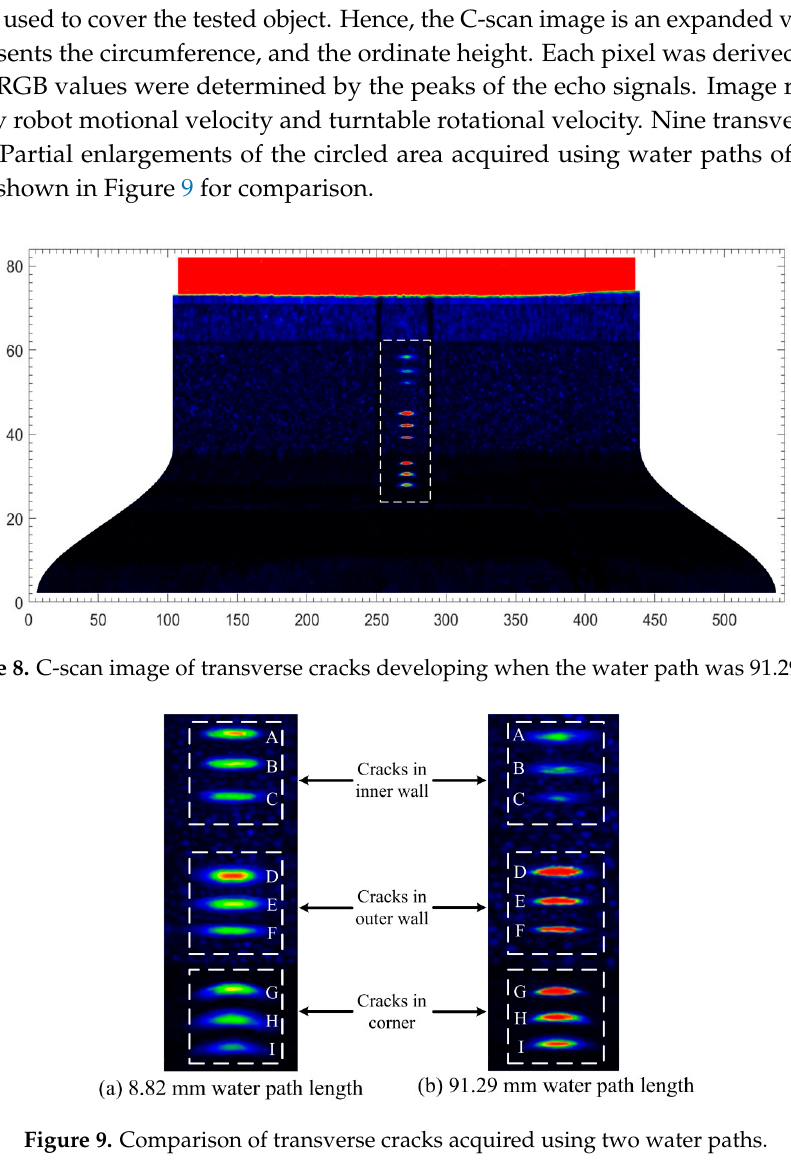
Figure 9. Comparison of transverse cracks acquired using two water paths.